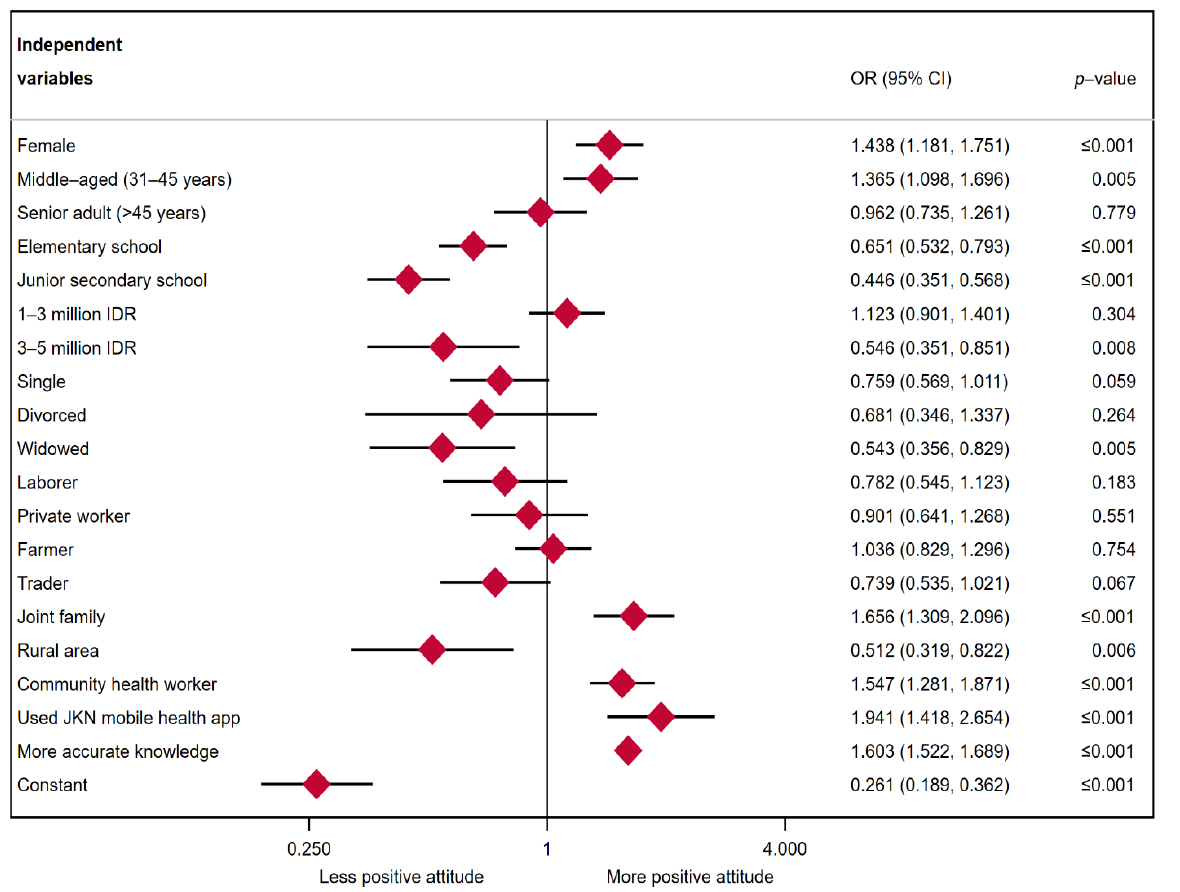
Figure 2. Multiple logistic regression results: attitudes towards COVID-19 prevention.